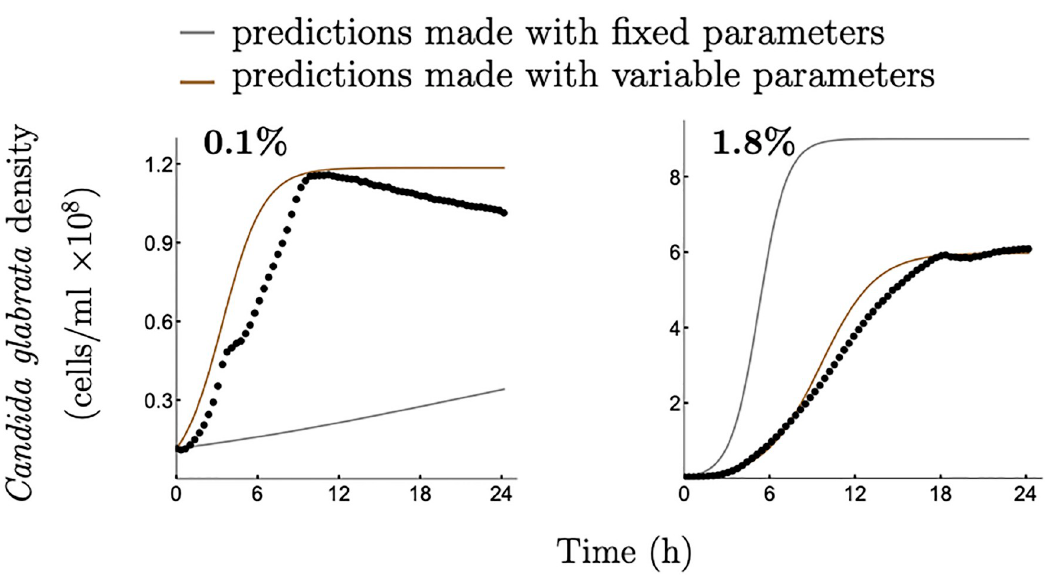
Fig 4. Comparison of growth predictions made by two modelling approaches, one using fixed and the other variable growth kinetic parameters. Experimentally obtained growth data for C. glabrata at different glucose concentrations (0.1%; 1.8%) are denoted by dots. Gray curves represent predictions of a model with fixed growth parameters estimated at the 1% initial glucose concentration (see S1 Text, Appendix B, B5 Fig (b) for growth data at 1% glucose). Brown curves represent predictions of a model with variable growth parameters as proposed in this study with [ a , b ] = [0.2%, 1.6%] in Step 1. To quantify the accuracy of the predictions made by the two approaches the Root Mean Square Error (RMSE) was calculated (see S1 Text, Appendix A, A9 Table for more details). Note, y-axis scale changes between